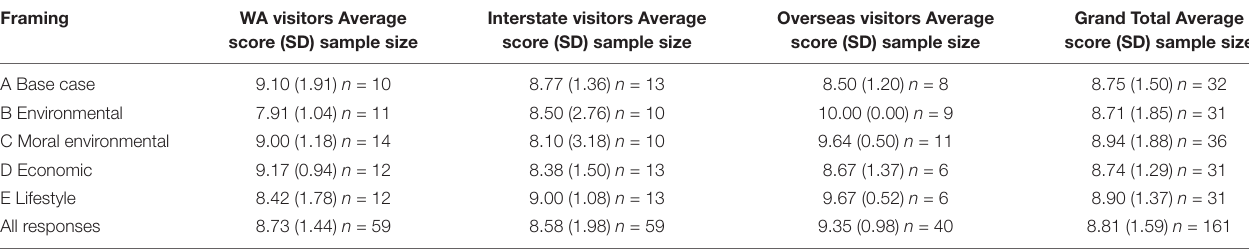
TABLE 7 | Scores of the five different framing messages ( n = 160*), which did not influence respondents’ answers to the survey. Framing